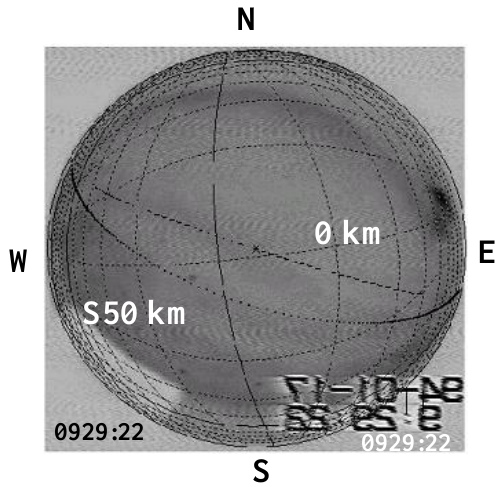
Figure 6. All-sky image taken at 09:29:22UT overlaid by the lines of geographic longitudes and latitudes, and the geomagnetic east– west lines passing the zenith of DWS (0km) and 50km south of DWS (S50km) by dotted lines. The brighter part of the auroras is shown in darker colors. The arc rotated clockwise with respect to the geomagnetic east–west